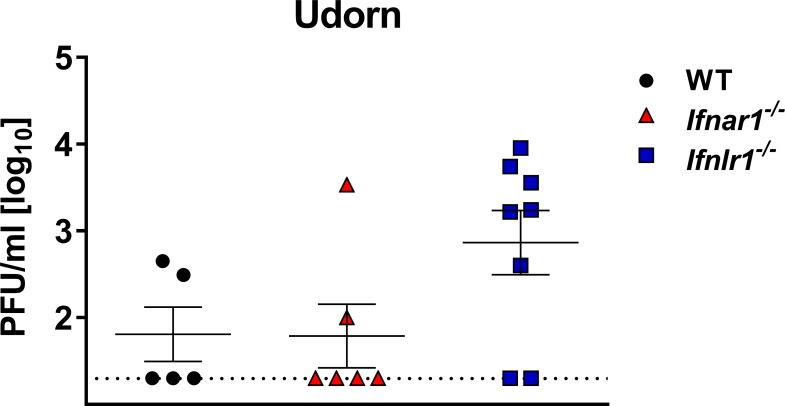
IFN-λ efficiently inhibits influenza virus replication in the upper airways under low dose infection conditions.WT (n = 5), Ifnar1−/− (n = 6) and Ifnlr1−/− (n = 8) mice were intranasally infected with 100 PFU of Udorn in a 10 µl volume. Upper airways were collected on day five post infection, and viral loads were determined by plaque assay. Symbols represent individual mice, and bars represent means ± SEM.